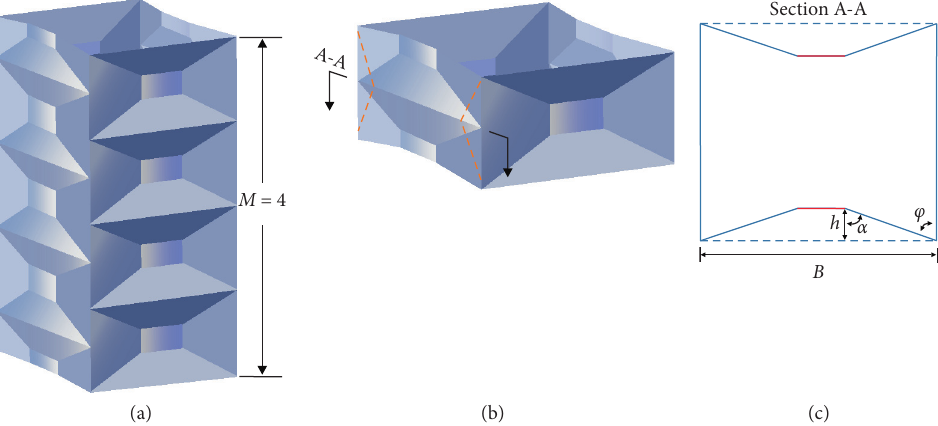
Figure 2: Geometry of the square tube with pyramidal elements: (a) square tube with M � 4, (b) a single module, and (c) a cross section of the